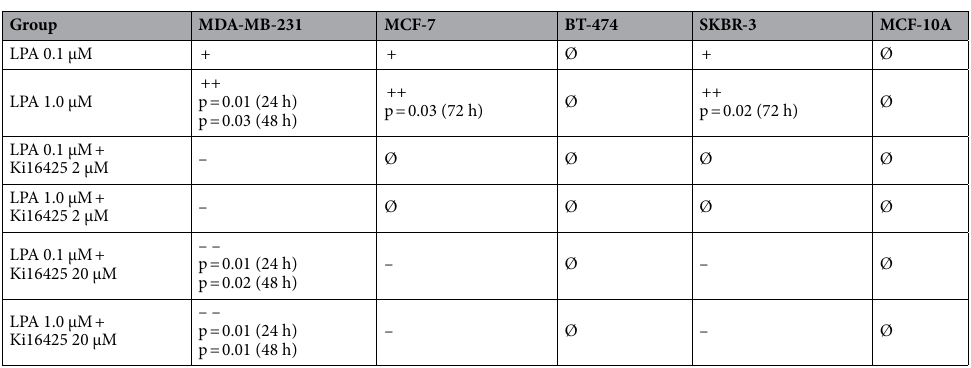
Table 4. Migration assay. Effect of lysophosphatidic acid (LPA) 18:1 and the LPA receptor 1, 3 (and 2) inhibitor Ki16425 on migration after 24 h, 48 h, and 72 h of different human breast (cancer) cell lines. n = 3 replicate experiments, a p-value ≤ 0.05 was considered significant (Kruskal–Wallis test and post-hoc Dunn’s test). Ø: no effect; +: stimulatory trend; ++: statistically significant stimulation; –: inhibitory trend; – –: statistically significant inhibition. For LPA 0.1 μM and LPA 1.0 μM stimulation was compared to the control group; for LPA 0.1 μM/LPA 1.0 μM + Ki16425 2/20 μM inhibition was compared to the respective LPA group without Ki16425.